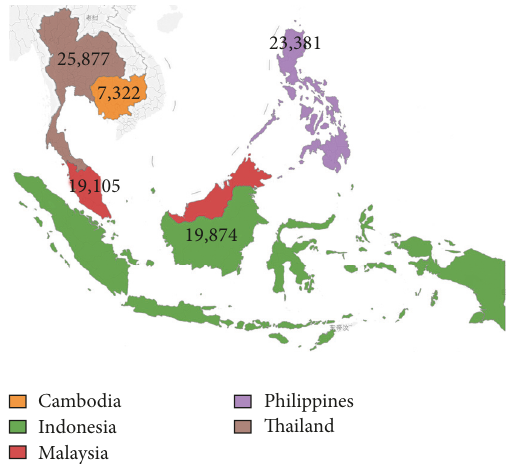
Figure 4: Mention counts of protest events occurring in Cambodia, Indonesia, Malaysia, Philippines, and Thailand extracted from GDELT between January 1, 2001, and February 29, 2016.